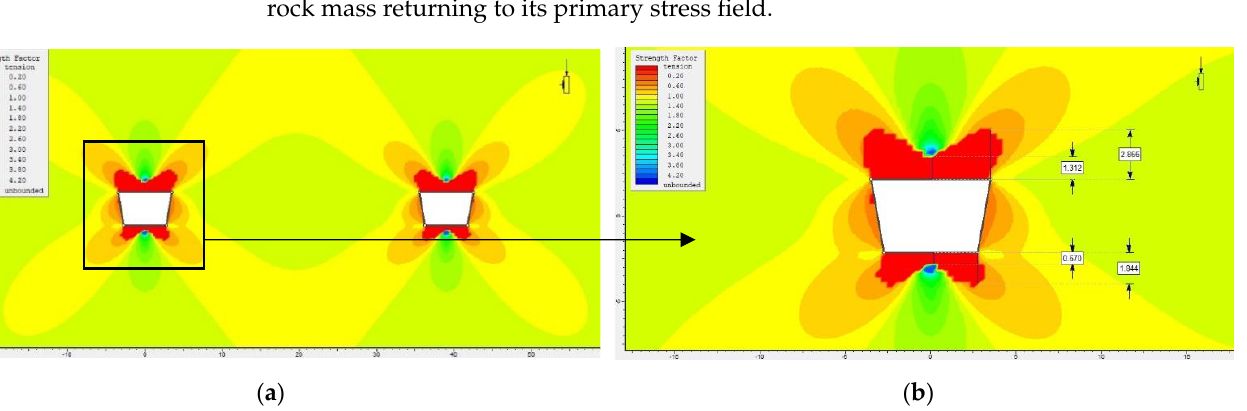
Figure 16. Distribution of strength factor values in the cross-section through ramps drilled in dolomite: ( a ) view of both headings; ( b ) close-up of a single excavation.